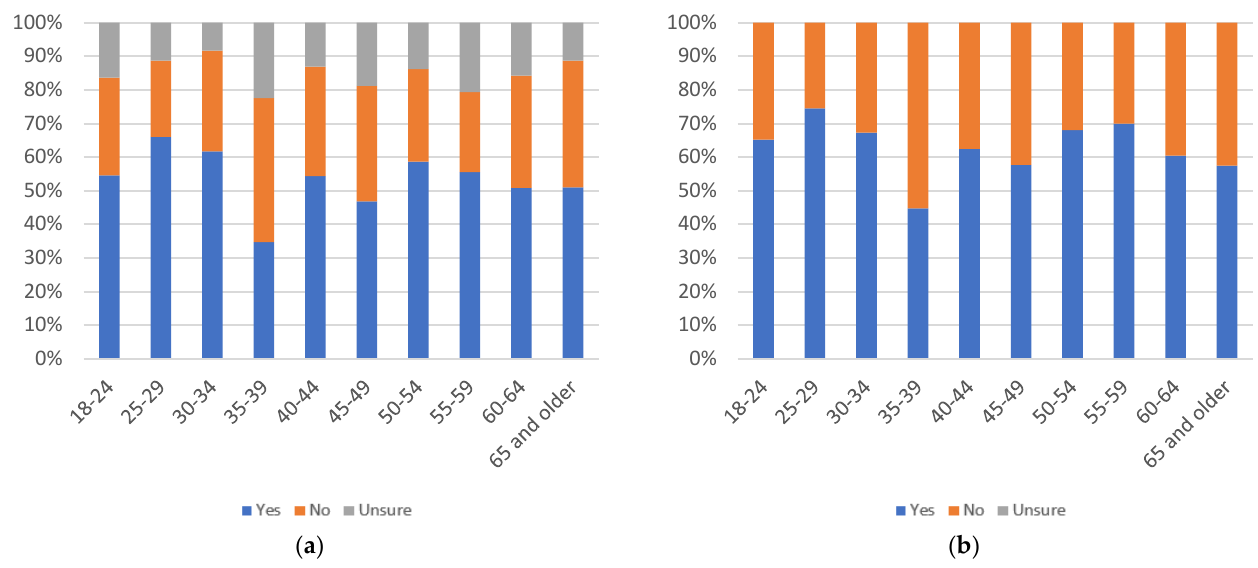
Figure 97. Label trustworthiness judging use, by age group: ( a ) with uncertain respondents (left) and ( b ) without uncertain respondents (right).